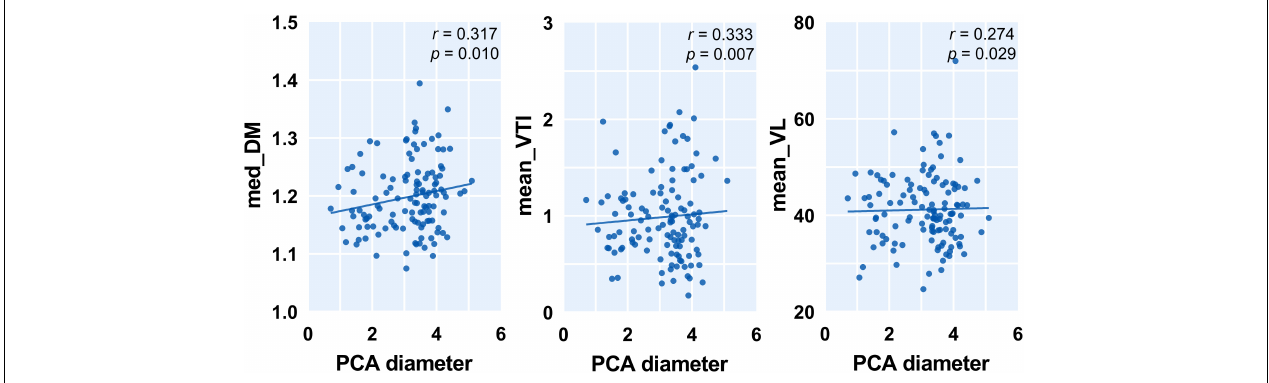
FIGURE 4 | Correlation between posterior cerebral artery (PCA) diameter and measurements of lenticulostriate arteries (LSAs). Med, medium; DM, distance metric; VTI, vessel tortuosity index; and VL, vessel length.